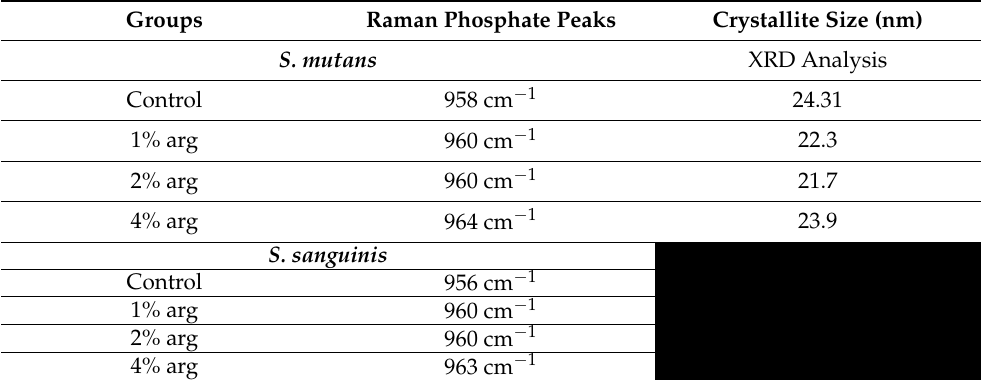
Table 2. Enamel Raman phosphate peaks and XRD analysis for crystallite size (in nm) with mono- species biofilms treated for 7